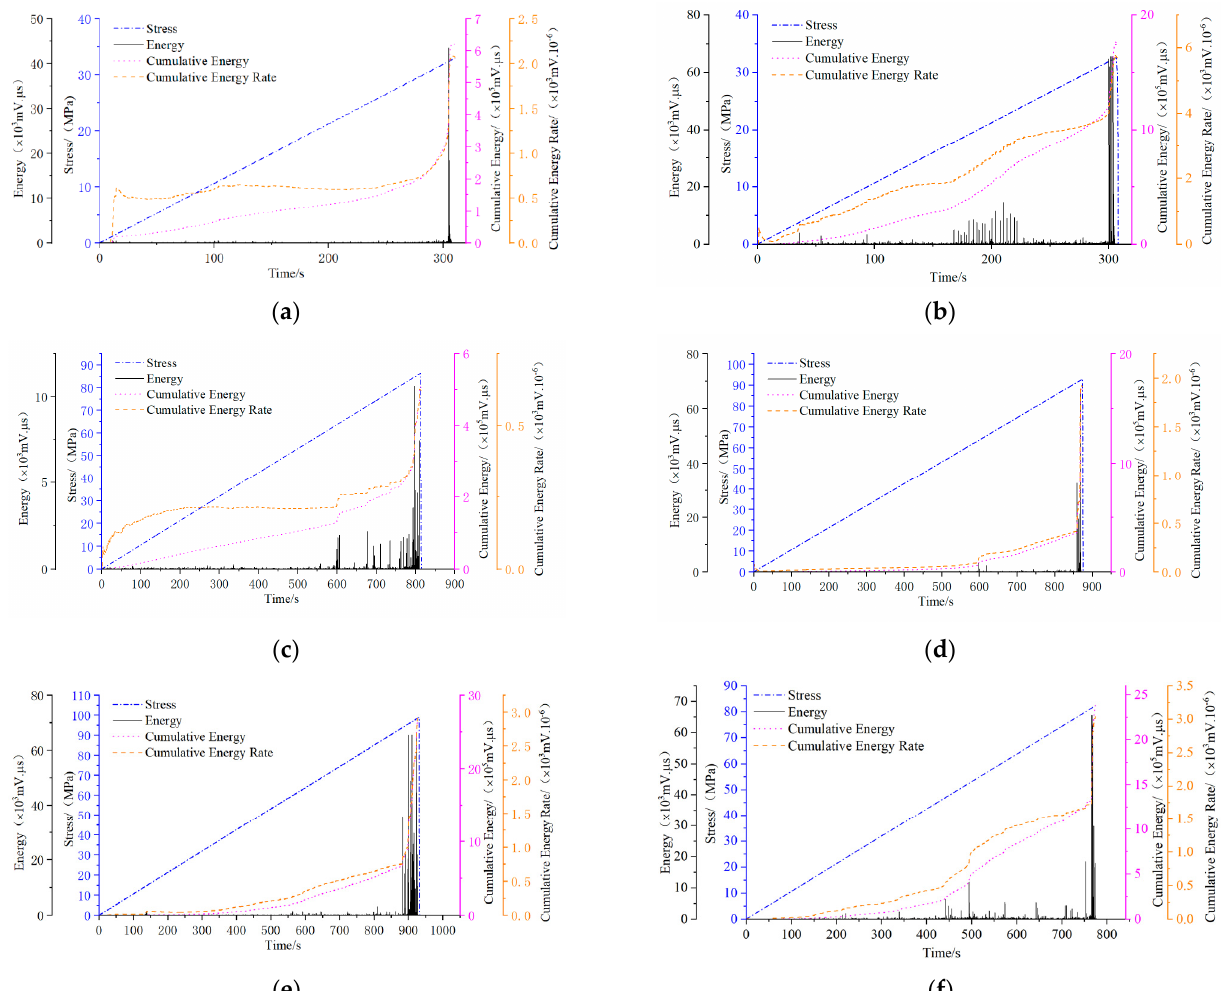
Figure 8. Relationship between AE characteristic parameters and loading time: ( a ) URC-0, ( b ) URC-5, ( c ) CRC-5, ( d ) JRC-0, ( e ) JRC-5, ( f ) JRC-10.